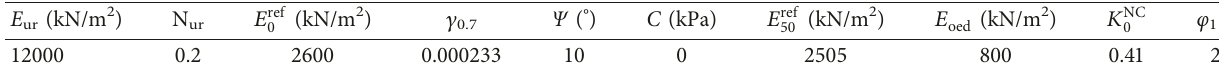
Table 4: Parameters of sand used in the finite element model.